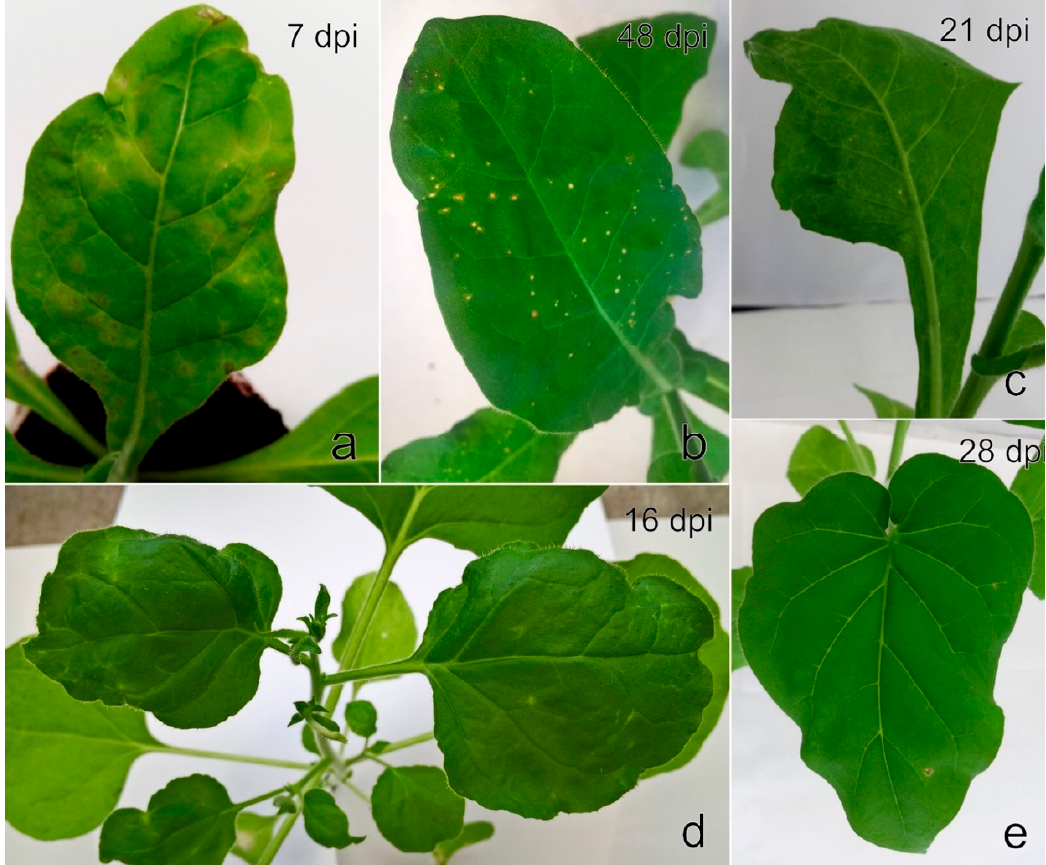
Figure 8. Nicotiana occidentalis 37B infected with StrV-1-1/2017 genotype B via A. fabae showing ( a ) yellowing and chlorotic and necrotic lesions one week from the beginning of aphid sucking and ( b ) systemic necrotic spots on identical plants in later stages of infection. ( c ) N. occidentalis 37B, ( d ) N. benthamiana DCL2/4i, and ( e ) N. glutinosa infected simultaneously with StrV-1- Č RM1 genotypes A and B by A. ruborum feeding exhibited light-green mosaic, irregular vein clearing with chlorotic dots, and sporadic necrotic lesions, respectively.